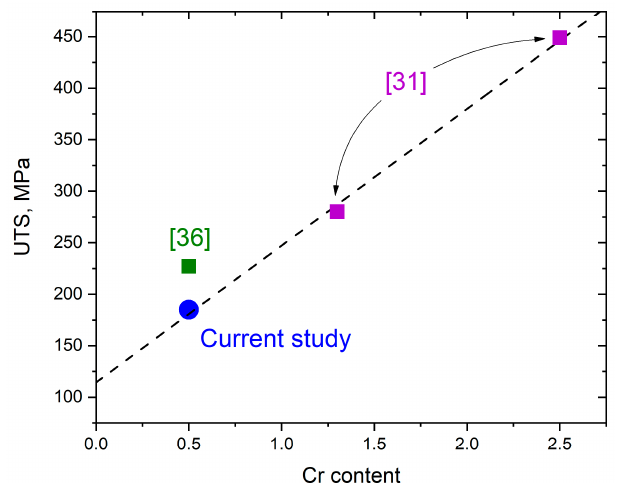
Figure 8. Comparison of UTS of Cu-Cr alloys depends on the chromium content obtained by Uchida et al. [31], Grigoryants et al. [36], and the current study.